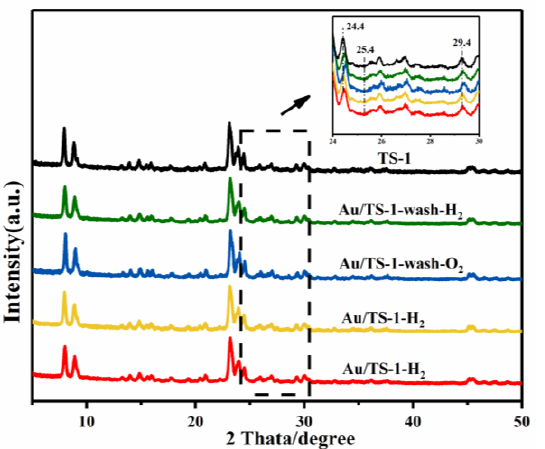
Figure 3. XRD pattern of TS-1 and the studied Au catalysts (inset: magnified region between 24° and 30°).